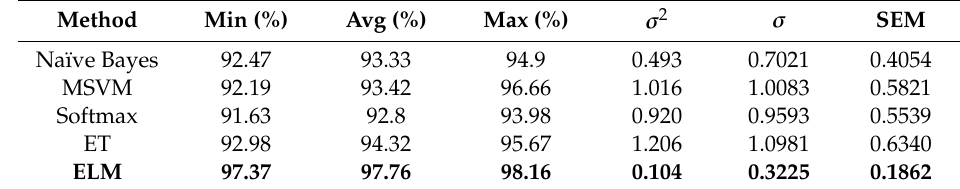
Table 10. Detailed statistical analysis of the proposed method using the BraTS 2015 dataset.